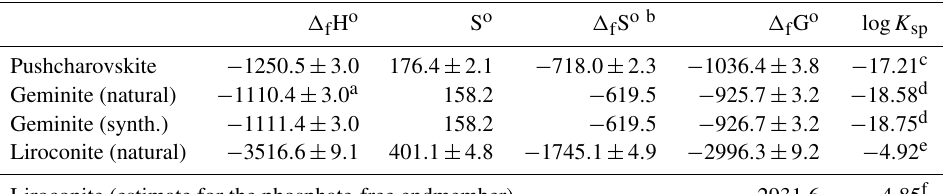
Table 9. Thermodynamic properties of the studied phases. (cid:49) f H o S o (cid:49) f S o b (cid:49) f G o log K sp Pushcharovskite − 1250 . 5 ± 3 . 0 176 . 4 ± 2 . 1 − 718 . 0 ± 2 . 3 − 1036 . 4 ± 3 . 8 − 17 . 21 c Geminite (natural) − 1110 . 4 ± 3 . 0 a 158.2 − 619 . 5 − 925 . 7 ± 3 . 2 − 18 . 58 d Geminite (synth.) − 1111 . 4 ± 3 . 0 158.2 − 619 . 5 − 926 . 7 ± 3 . 2 − 18 . 75 d Liroconite (natural) − 3516 . 6 ± 9 . 1 401 . 1 ± 4 . 8 − 1745 . 1 ± 4 . 9 − 2996 . 3 ± 9 . 2 − 4 . 92 e Liroconite (estimate for the phosphate-free endmember) − 2931 . 6 − 4 . 85 f The formation reactions are defined in Table 10, reactions (cid:49) H 18 , (cid:49) H 19 and (cid:49) H 20 . All enthalpy and Gibbs free-energy values are in kilojoules per mole, and all entropy values are in joules per mole per kelvin. a Corrected for the arsenolite impurity. b Calculated from the entropies of elements in their standard state (from Robie and Hemingway, 1995). c–f Solubility products were calculated with these auxiliary data (kJmol − 1 ) : (cid:49) f G o ( Cu 2 + , aq ) = + 65 . 1 ± 0 . 1 (Robie and Hemingway, 1995), (cid:49) f G o ( AsO 3 − 4 , aq ) = − 647 . 6 ± 1 . 5 (Nordstrom et al., 2014), (cid:49) f G o ( PO 3 − 4 , aq ) = − 1025 . 5 ± 1 . 6 (Grenthe et